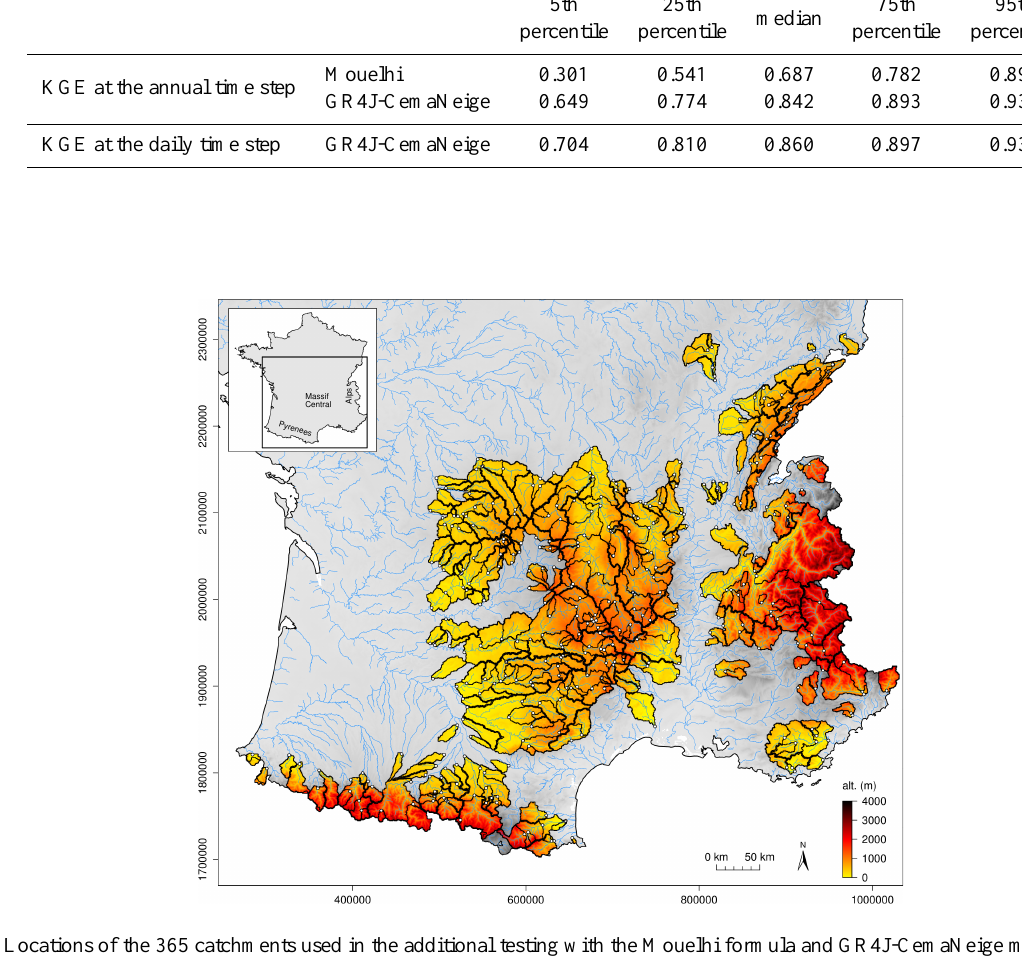
Table A2. Model efficiencies computed over the total available records, considering sub-period calibrated parameter sets [KGE TP ] θ (results for the enlarged catchment set).